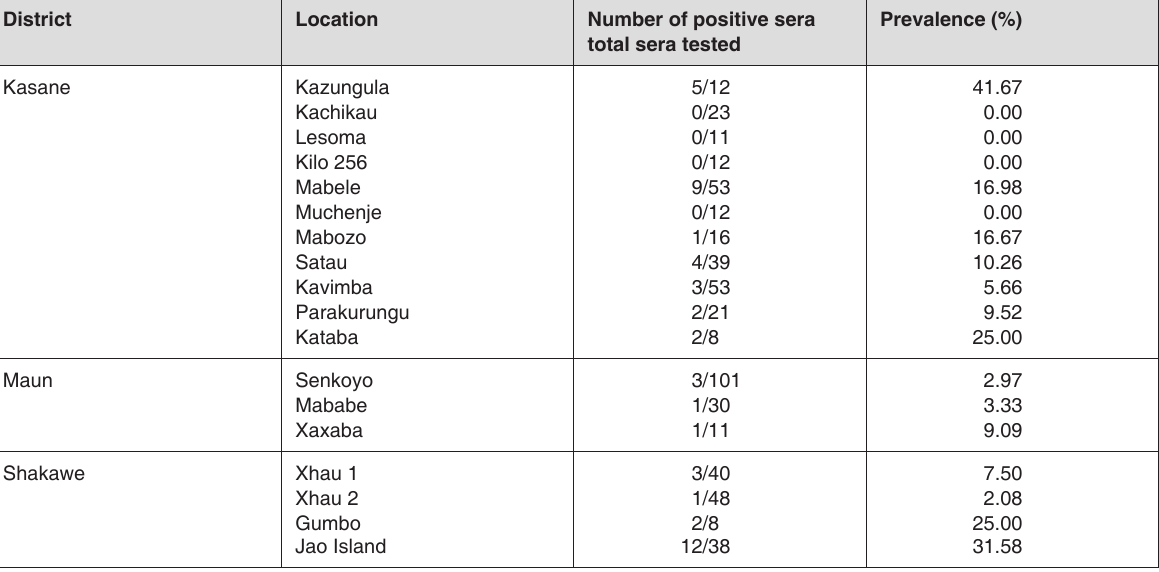
TABLE 2 Prevalence of FMD antibodies in indigenous goats within several locations of three districts in northwestern Botswana District